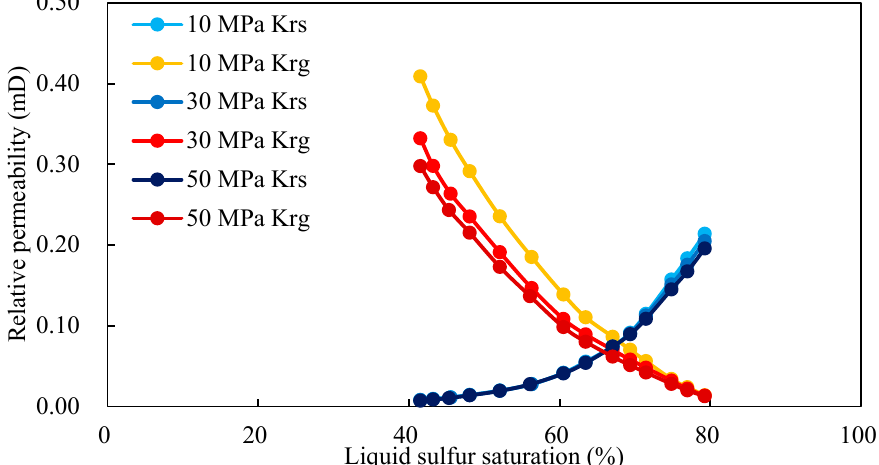
Figure 7. Gas–liquid sulfur relative permeability curves of Core 1 at different confining pressures.